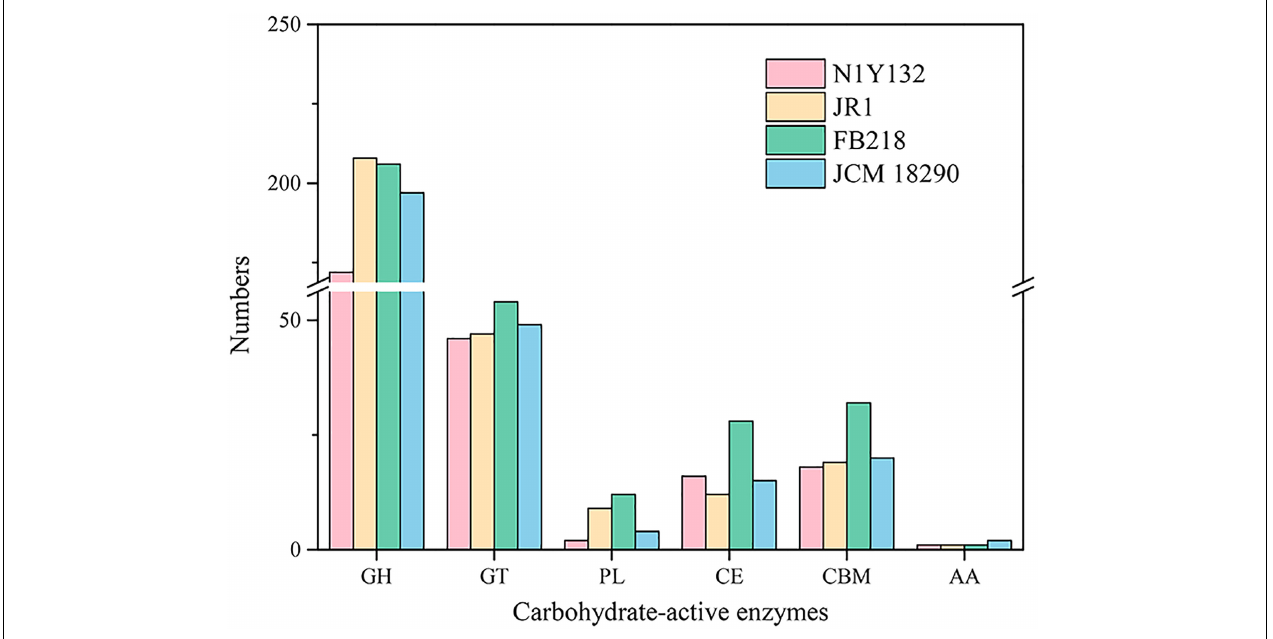
FIGURE 5 | Histogram of predicted carbohydrate-active enzymes (CAZymes) in strain N1Y132 T , C. sediminis JR1 T , C. linearis FB218 T , and C. mesophila JCM 18290 T . Numbers of each enzyme detected in the genome were shown in the map.